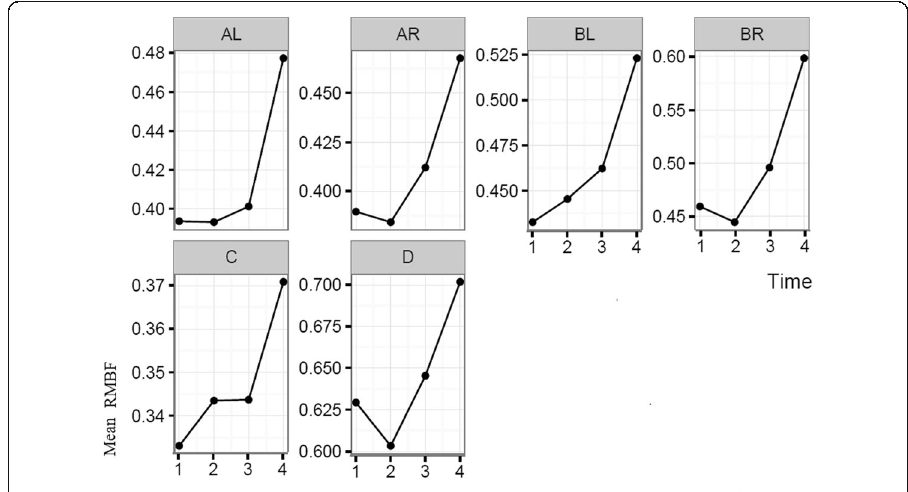
Fig. 2 Mean regional microcirculation blood flow (RMBF) from baseline for all subjects at each anatomical region of interest, over time. Time-points (T1 – T4) on the x axis; mean RMBF on the y